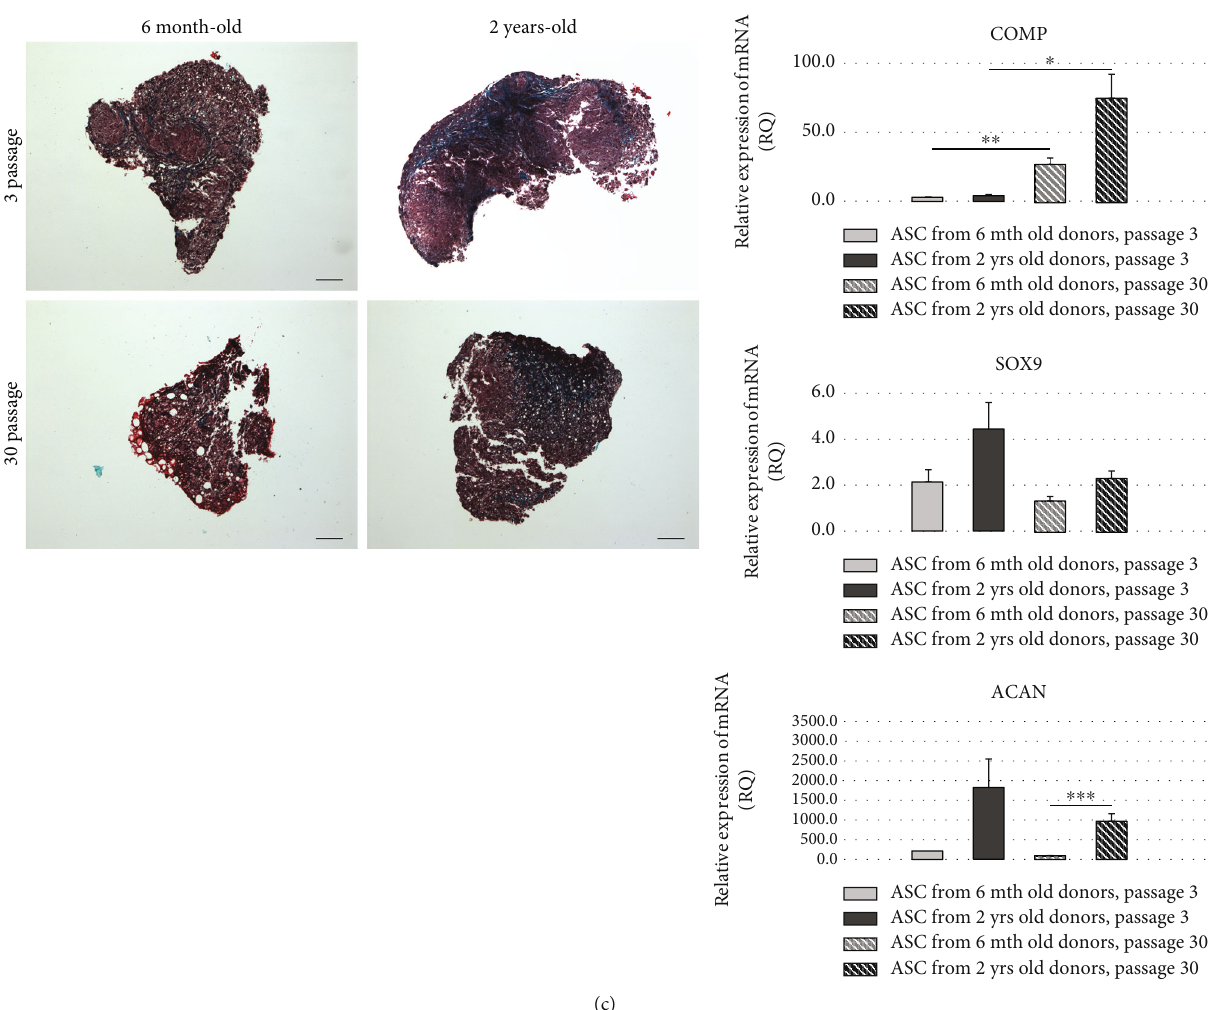
Figure 3: (a) Adipogenic di ff erentiation of ASCs from 6 mth donors, p. 3; 2yrs. donors, p. 3; 6mth donors, p. 30; 2 yrs. donors, p. 30 and comparison of adipogenesis-speci fi c gene expressions of CEBPA, ADIPOQ, and PPAR γ in adipogenic-stimulated ASCs from young (6 mth) and aged rats (2 yrs.) cultured for 3 or 30 passages; (b) osteogenic di ff erentiation of ASCs from 6mth donors, p. 3; 2yrs. donors, p. 3; 6 mth donors, p. 30; 2yrs. donors, p. 30 and comparison of osteogenesis-speci fi c gene expressions of ALPL, RUNX2, and IBSP in adipogenic-stimulated ASCs from young (6 mth) and aged rats (2 yrs.) cultured for 3 or 30 passages; (c) chondrogenic di ff erentiation of ASCs from 6mth donors, p. 3; 2yrs. donors, p. 3; 6mth donors, p. 30; 2yrs. donors, p. 30 and comparison of chondrogenesis-speci fi c gene expressions of COMP, SOX9, and ACAN in adipogenic-stimulated ASCs from young (6 mth) and aged rats (2 yrs.) cultured for 3 or 30